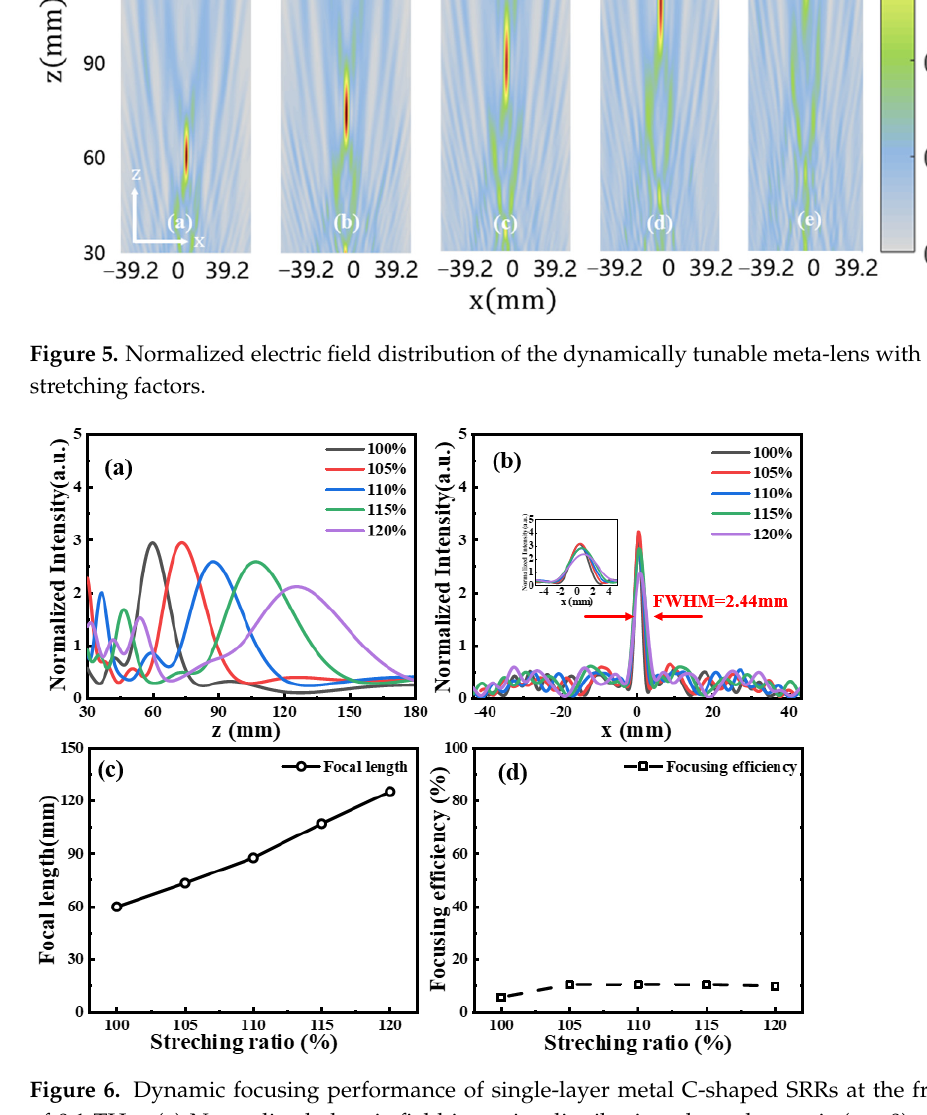
Figure 5. Normalized electric field distribution of the dynamically tunable meta-lens with different stretching factors.